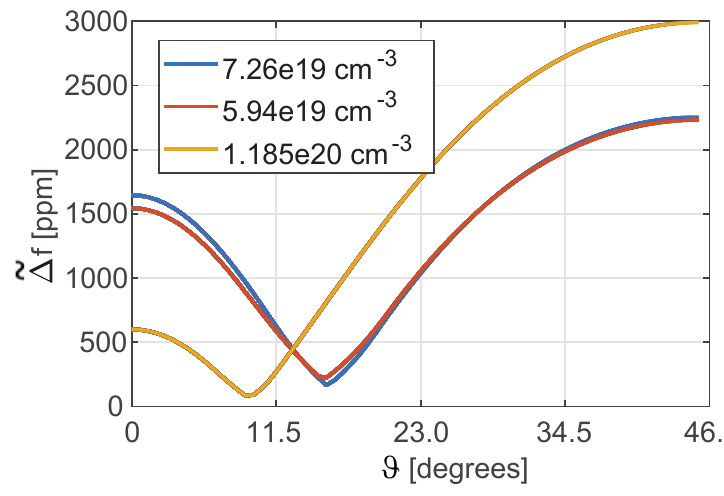
Figure 4. Maximum temperature variation of the natural frequency of the tuning fork in the range [ − 35 ◦ C–85 ◦ C] for different orientations of the device with respect to the silicon wafer and for different dopings of the silicon.